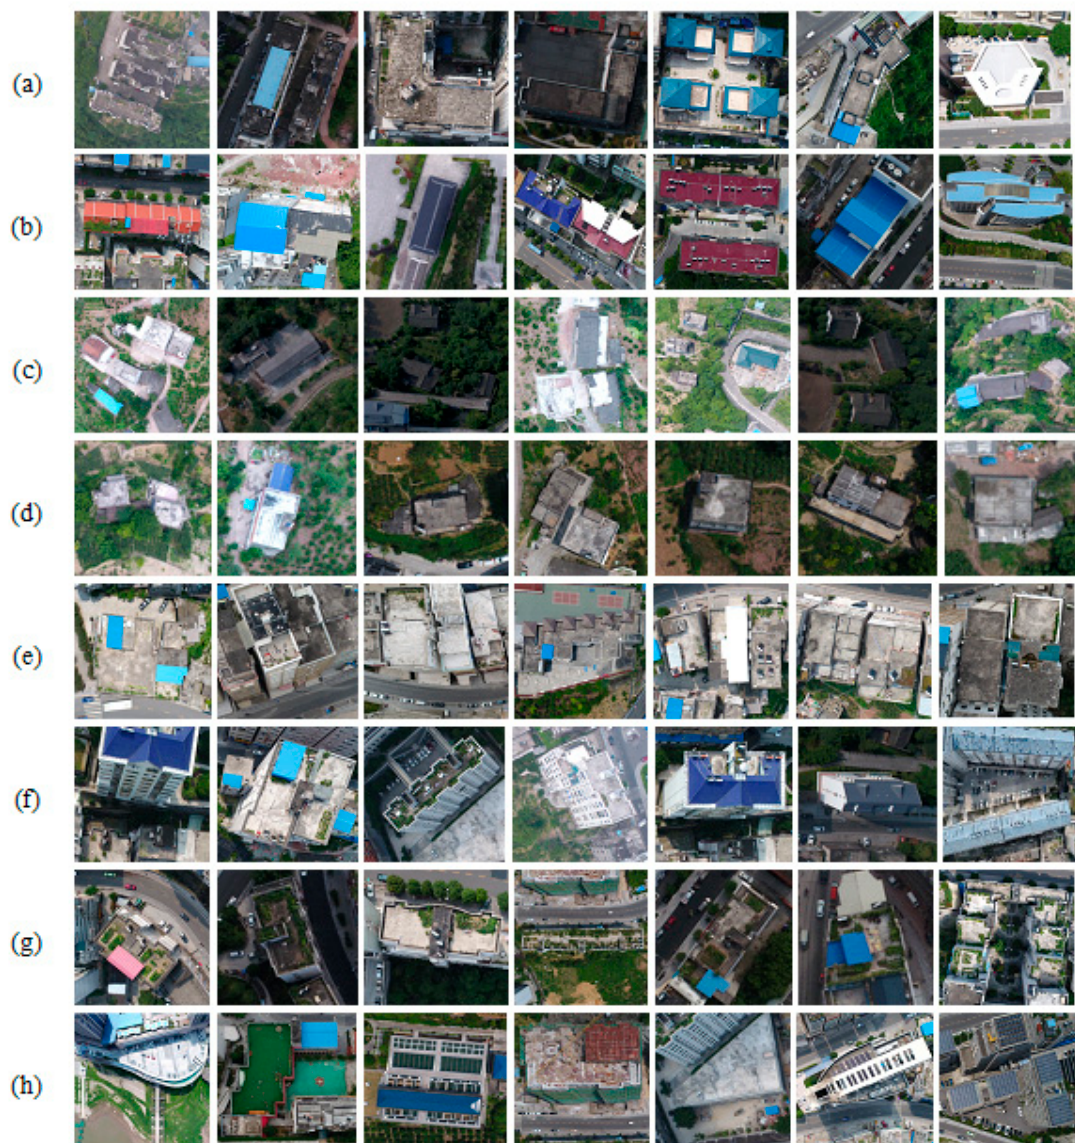
Figure 2. Buildings with different perspectives in study area. ( a ) building architectures; ( b ) high and medium-size building rooftops; ( c ) small-size building rooftops; ( d ) small building rooftops; ( e ) dense and tall buildings; ( f ) different sides of a building; ( g ) greening on building roofs; ( h ) playground on building roofs.